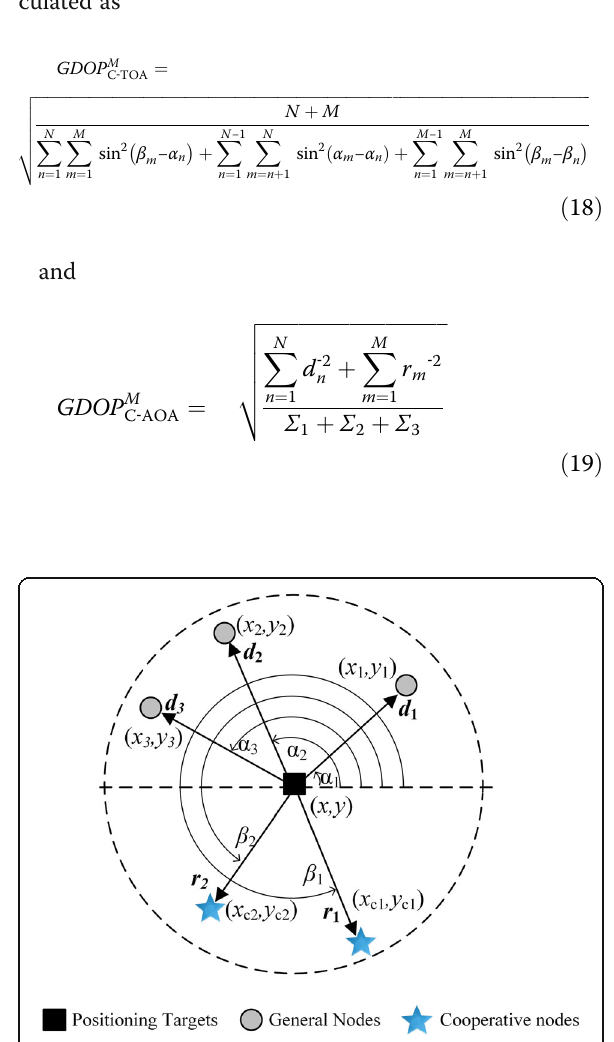
Fig. 2 Geometry of the nodes in two-dimensional cooperative localization